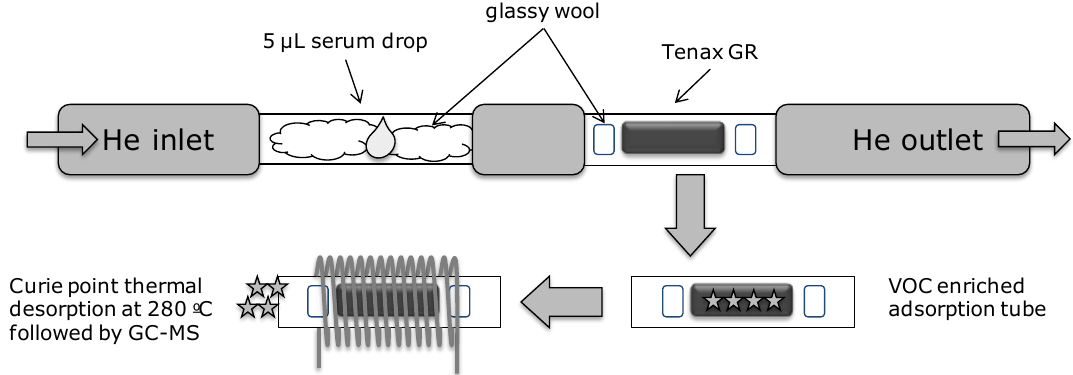
Figure 1. Schematic illustration of sample preparation before injection into the gas-chromatograph